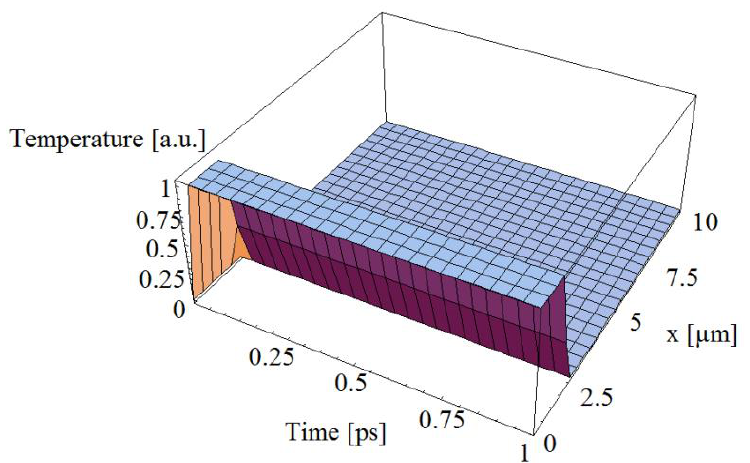
Figure 3. Spatial-temporal distribution of the electrons’ thermal field generated by one laser pulse on an Au surface, when t = 100 fs and τ = 1 ps versus time (1 ps).